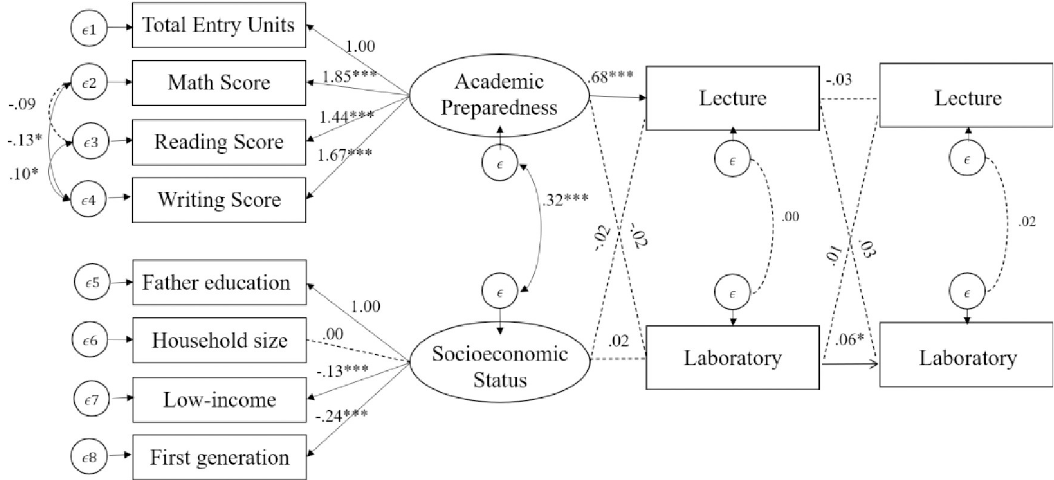
Fig 1. Cross-lagged panel analysis of chemistry lecture and inquiry-based lab course sections. CFI = .97, TLI = .96, RMSEA = .04 [.03, .04], SRMR = .03, N = 2,865; p < .05., �� p < .01., ��� p < .001.